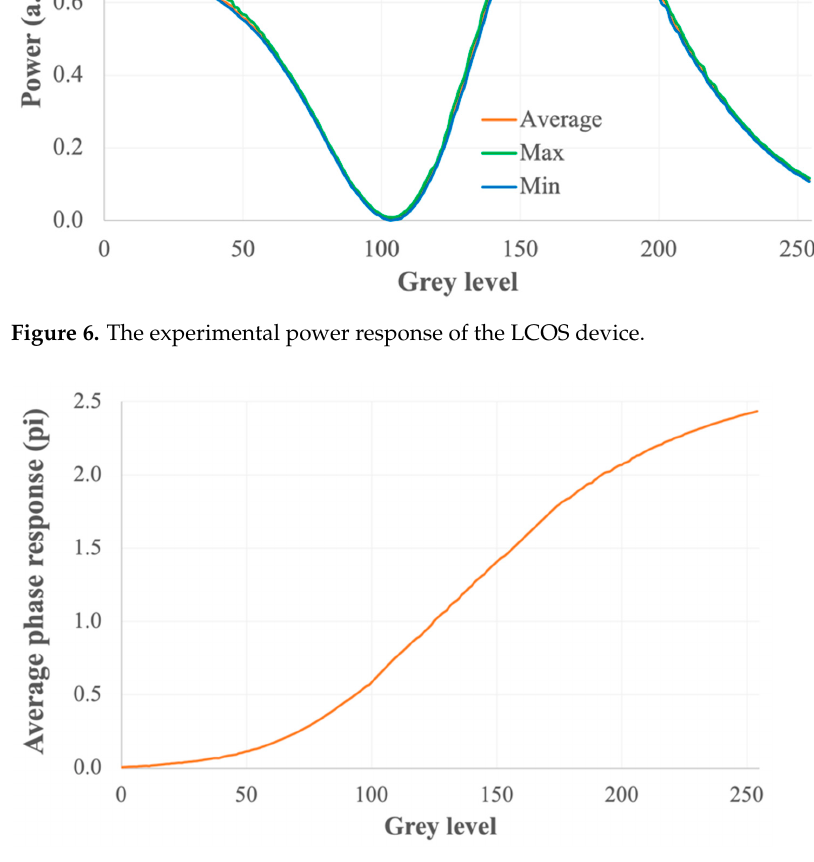
Figure 8. The calculated phase flicker of the LCOS device based on the experimental results.